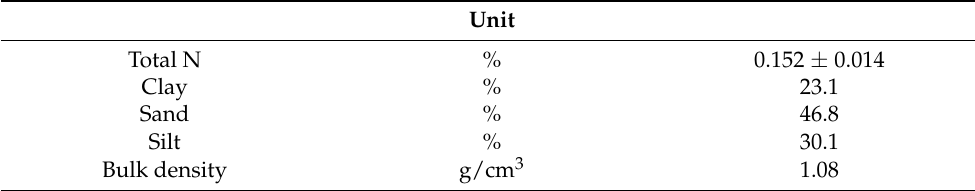
Table 1. Main soil physical parameters and N content at the 0–30 cm soil depth. Unit Total N % 0.152 ± 0.014 Clay % 23.1 Sand % 46.8 Silt % 30.1 Bulk density g/cm 3